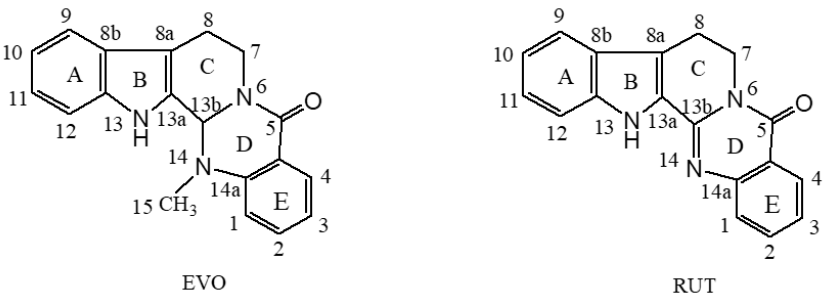
Figure 1. The molecular structures of evodiamine (EVO) and rutaecarpine (RUT). Ring labeling is represented by A, B, C, D, and E, while atom numbering is represented by numbers and lowercase letters.